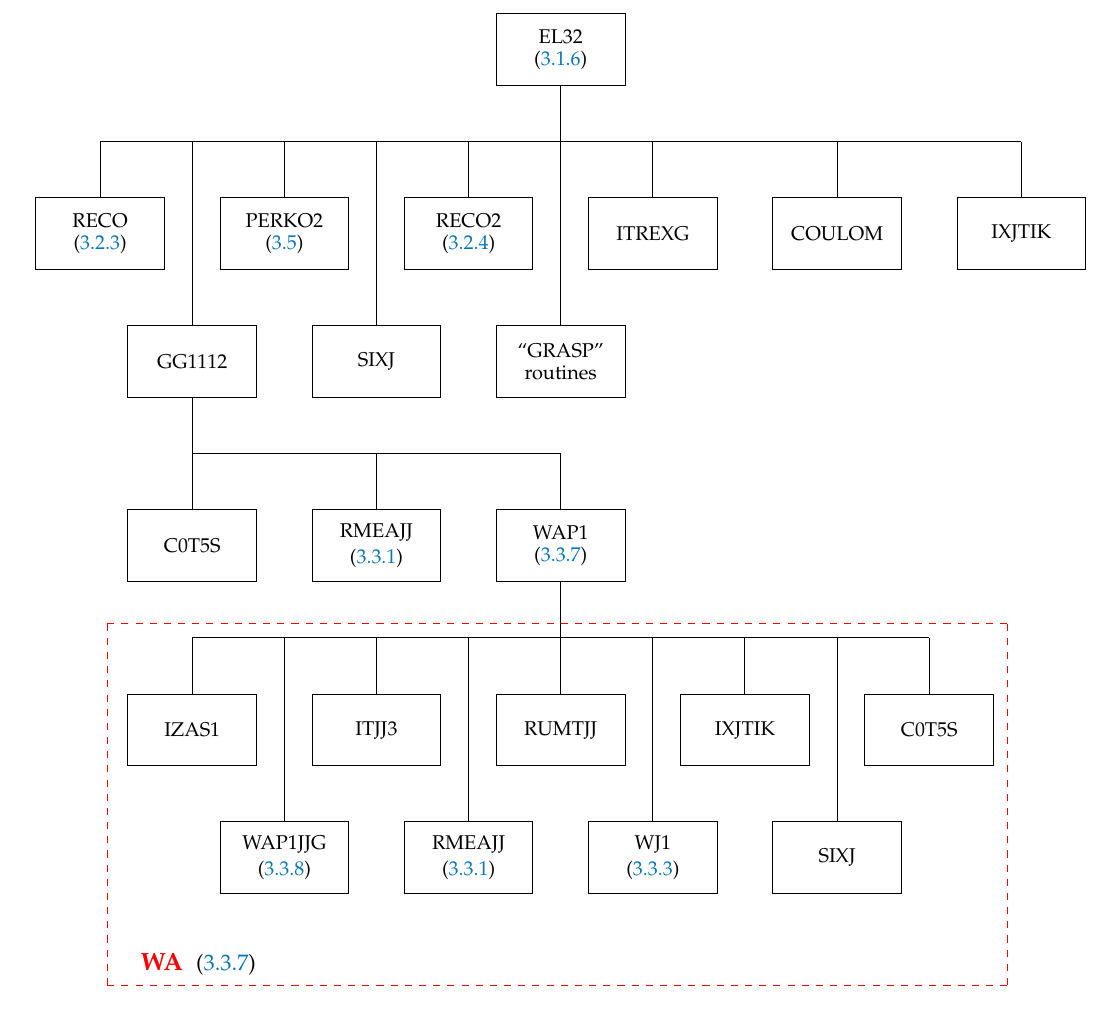
Figure 6. Structure of the subroutine EL32 . The box “GRASP” routines correspond to the routines SNRC , CXK , SPEAK , and TALK from the GRASP92 package [54]. The red frame WA shows the structure of the routine WAP1 (computing the matrix element (93)) to which the subroutine EL32 explicitly is